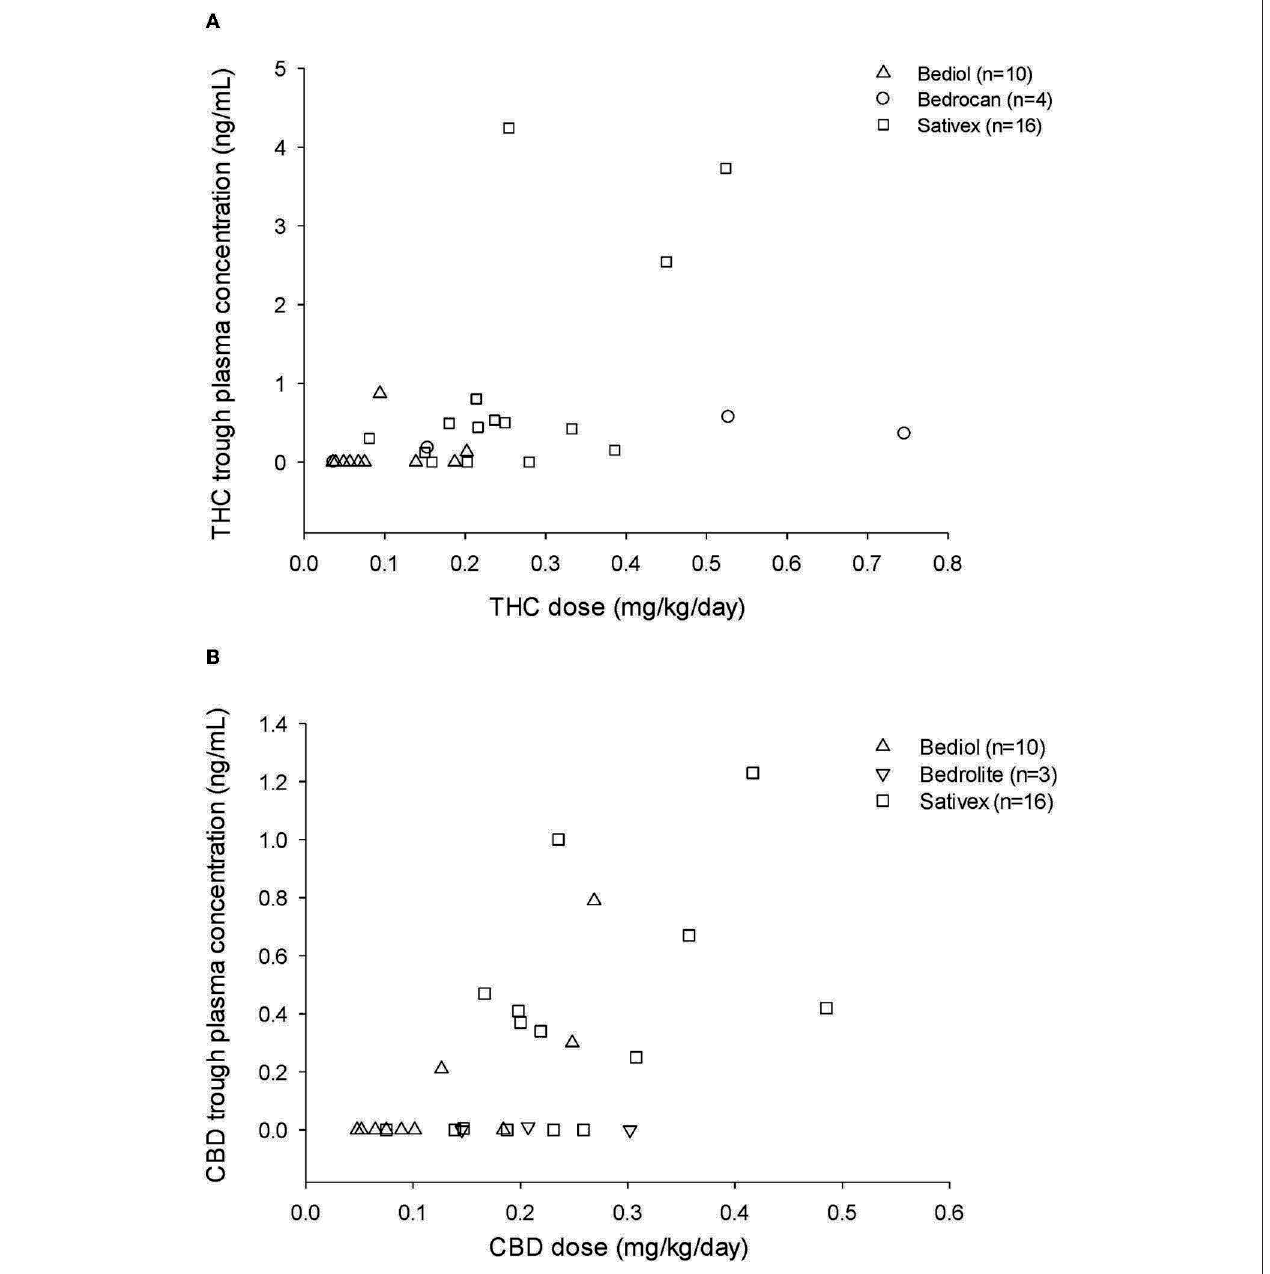
FIGURE 1 | Tetrahydrocannabinol (THC) (A) and cannabidiol (CBD) (B) trough plasma concentrations and matched daily doses (mg/kg/day) by different types of cannabis-based products.